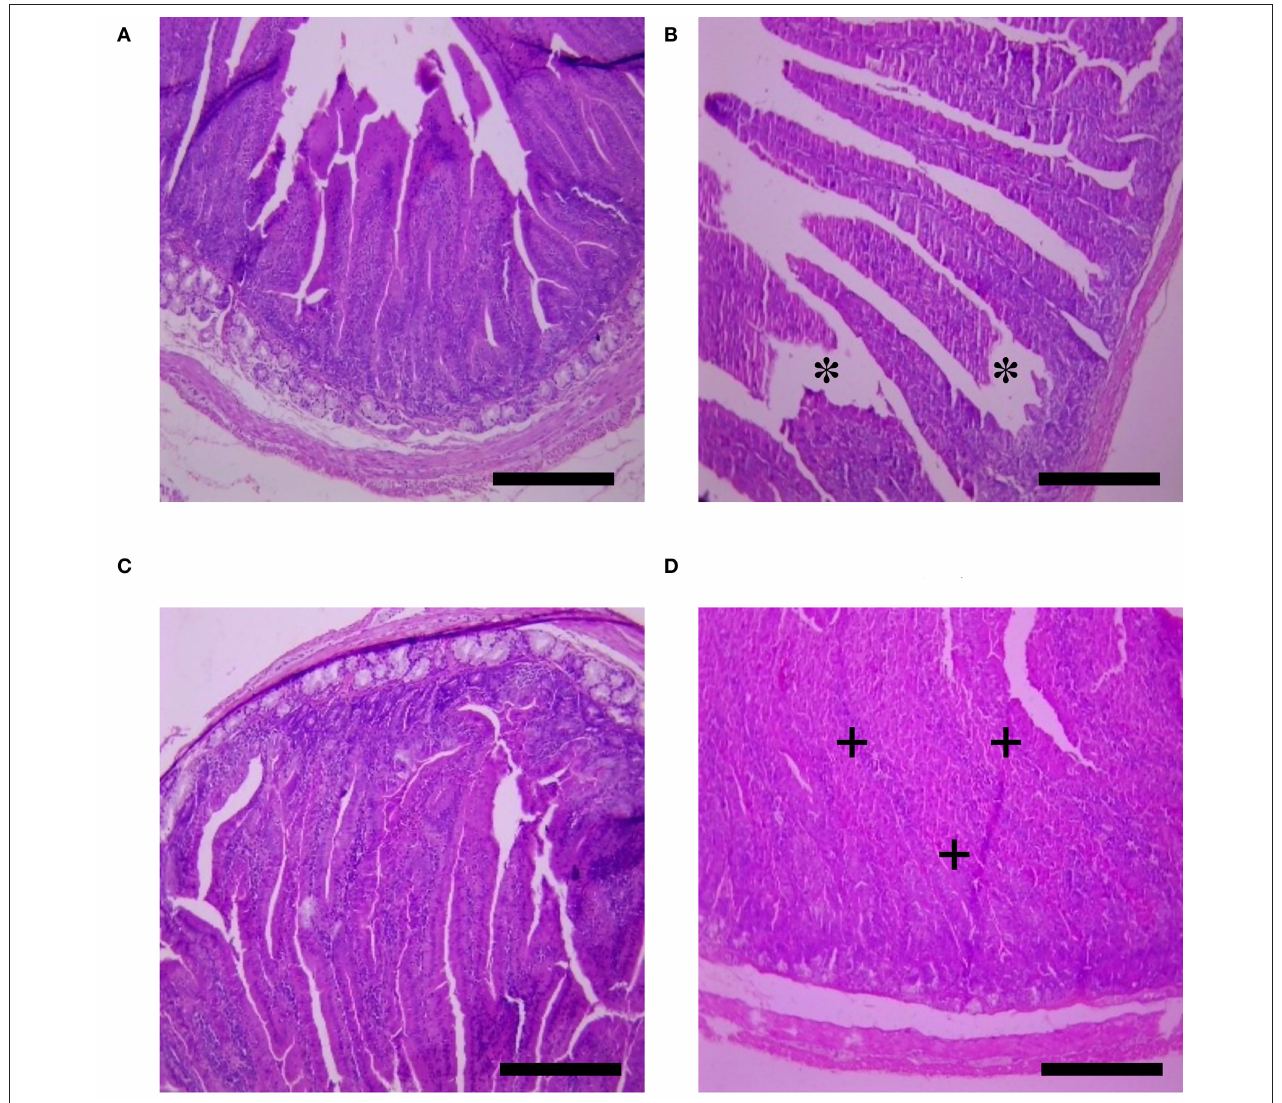
FIGURE 1 | Histological sections of small intestines of layers exposed to heat stress (HS) and supplemented with organic selenium-enriched yeast (SY) in the basal diet (scale bars 25 µ m). (A) Layers exposed to thermoneutral temperature at 24 ◦ C and fed a basal diet without SY supplementation; (B) Layers exposed to HS at 35 ◦ C and fed a basal diet without SY supplementation; (C) Layers exposed to HS at 35 ◦ C and fed a basal diet supplemented with 0.4 g/kg SY; (D) Layers exposed to thermoneutral temperature at 24 ◦ C and fed a basal diet supplemented with 0.4 g/kg SY. Asterisks (*) indicate the disruption of intestinal villi, while plus signs ( + ) indicate the integrity of intestinal